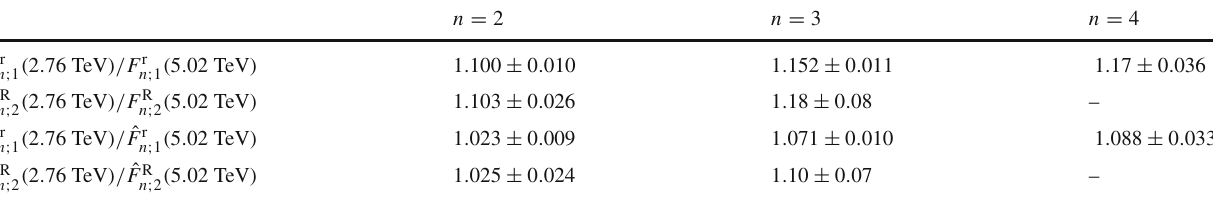
Table5 Resultsofthefitstotheratioof F r shown in Figs. 13 and 14. The uncertainties include both statistical and systematic